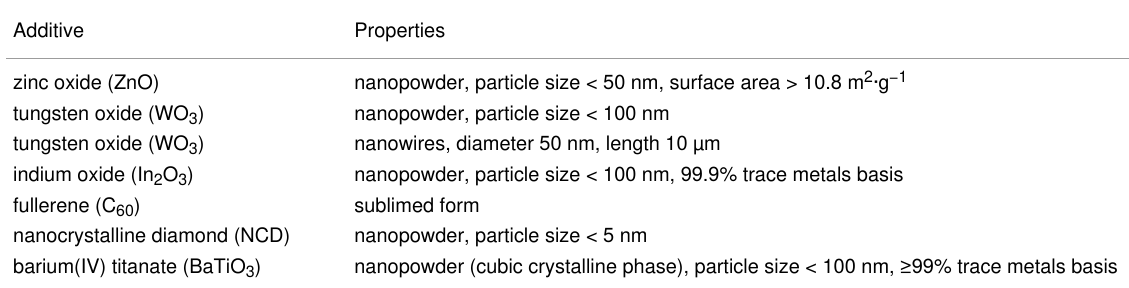
Table 3: Properties of the used additives. Additive